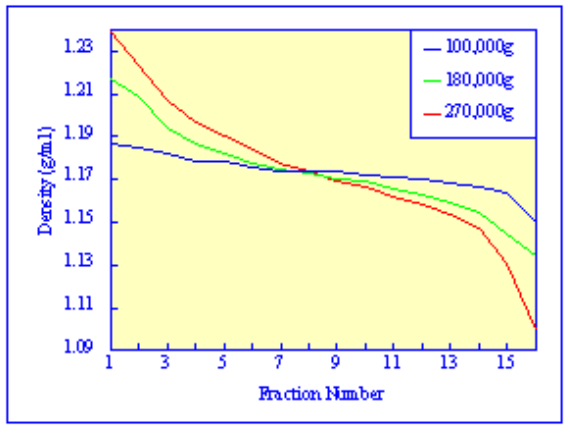
FIGURE 5 . Density profiles: 30% iodixanol in a Kontron 70.38 rotor, centrifuged for 3 h at 4 o C at 180,000 g .